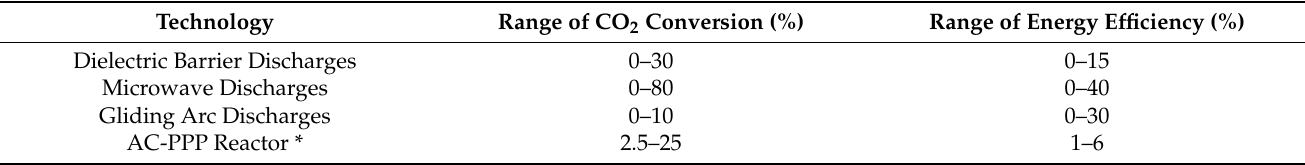
Table 4. Comparison of CO 2 conversion factor and energy efficiency for different plasma technologies [7]. Technology Range of CO 2 Conversion (%) Range of Energy Efficiency (%) Dielectric Barrier Discharges 0–30 0–15 Microwave Discharges 0–80 0–40 Gliding Arc Discharges 0–10 0–30 AC-PPP Reactor * 2.5–25